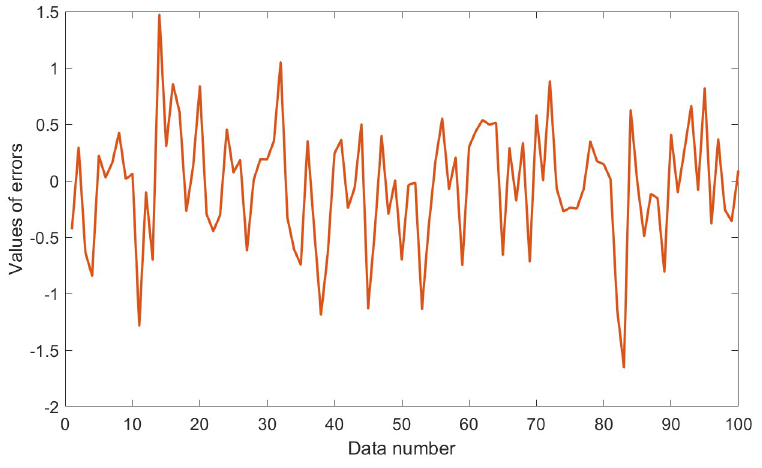
Fig 2. Values of errors in dataset